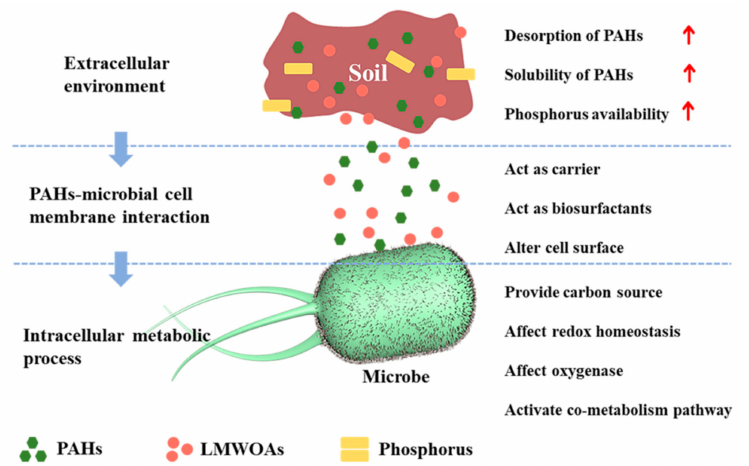
Figure 1. The influence of low molecular weight organic acids (LMWOAs) on the microbial degrada- tion process of polycyclic aromatic hydrocarbons